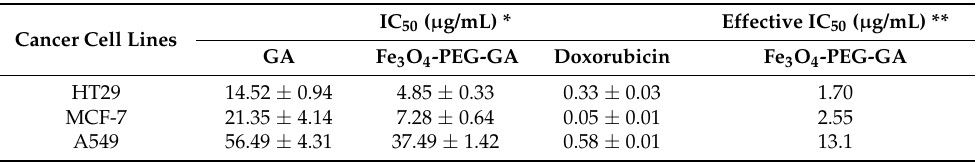
Table 1. The IC 50 values of GA, Doxorubicin and Fe 3 O 4 -PEG-GA on cancer cell lines. IC 50 ( µ g/mL) Cancer Cell Lines